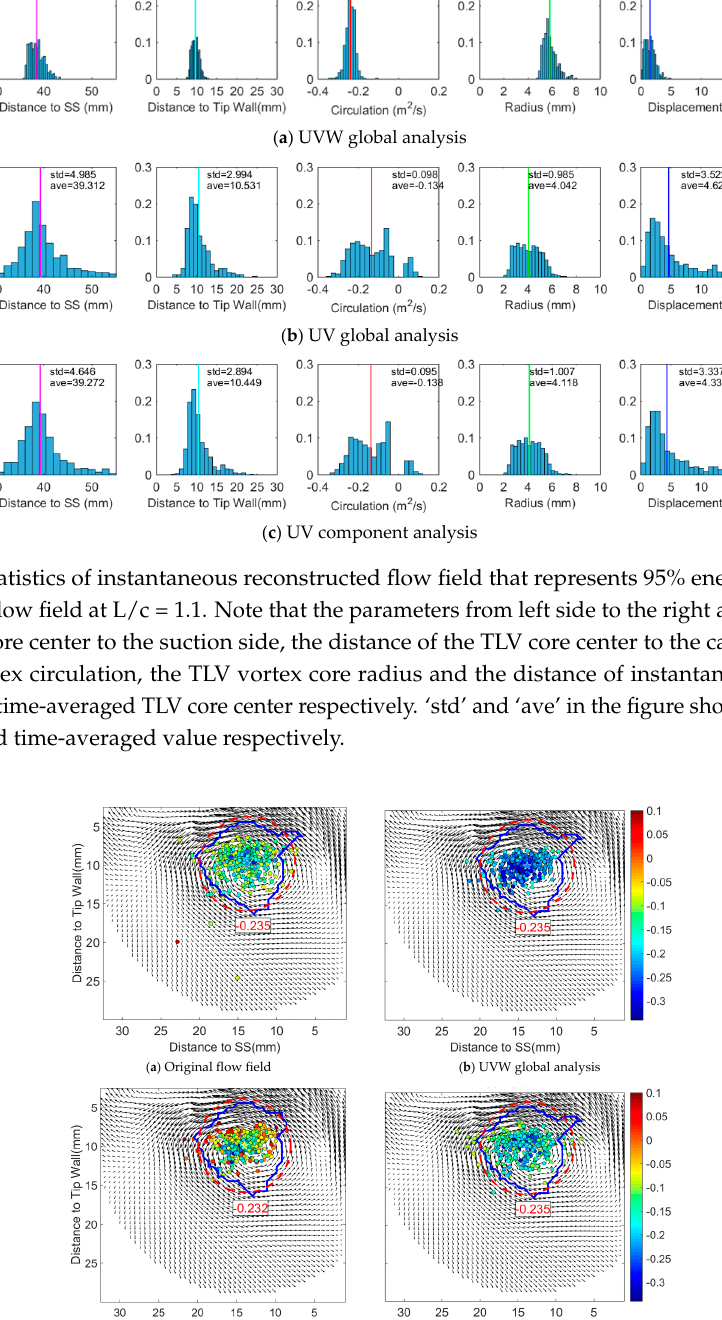
Figure 22. Cont. Figure 22 .Vortex distribution from reconstructed flow field using first 10 modes at L/c = 1.1. Figure 22. Vortex distribution from reconstructed flow field using first 10 modes at L/c =